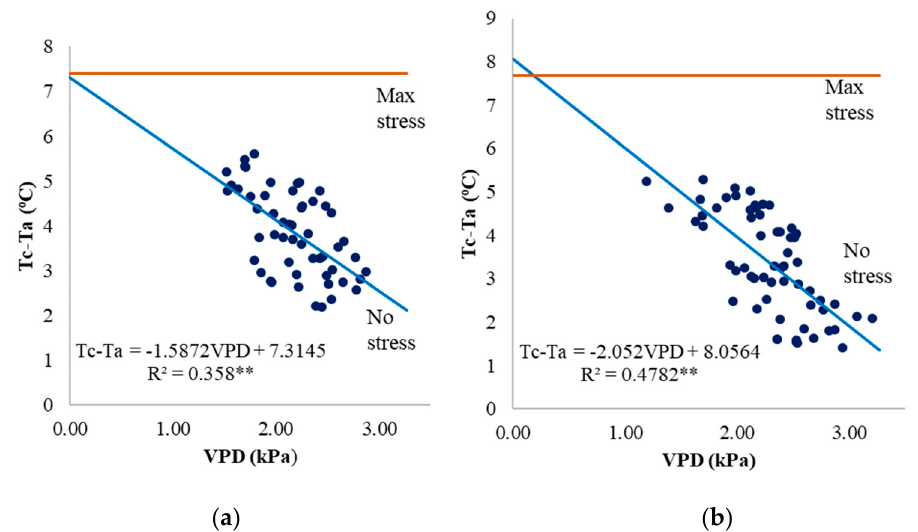
Figure 2. Stressed and non-stressed baselines for Crop Water Stress Index (CWSI) calculations of ( a ) cool–season turf types and ( b ) warm-season turf type (** p < 0.01). However, many researchers pointed out that crop and local conditions could impact on the baseline relation, causing differentiation [15,31,33,34]. Seasonal CWSI values and average CWSI values just before irrigation are presented in Figure 3. All CWSI values in CS turf are a little bit higher than those of WS turf. According to these results, it can be said that CS turf is more sensitive to drought in respect to WS turf. Besides, the lowest value of CWSI was observed in I30 treatments and the highest one was reached in I70 treatments for both turf species. The seasonal mean values of the CWSI for the full irrigated treatments were found as 0.16 and 0.15 for the I30 of CS and WS, while the mean CWSI values for the stressful treatments were 0.40 and 0.27 for the I70 subjects, respectively.